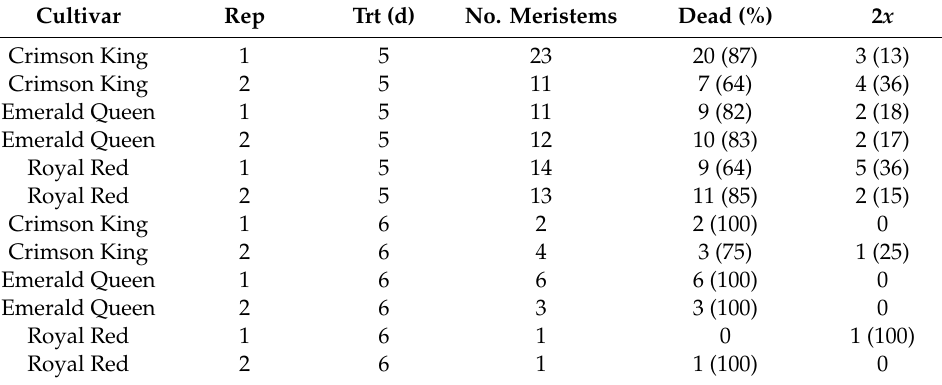
Table 2. Meristems of Acer platanoides cultivars after treating with 100 µ M oryzalin supplied as Surflan and solidified with 0.8% agar during 2011. Meristems were exposed by removing bud scales and submerging in agar-solidified oryzalin solution for 5 or 6 d.